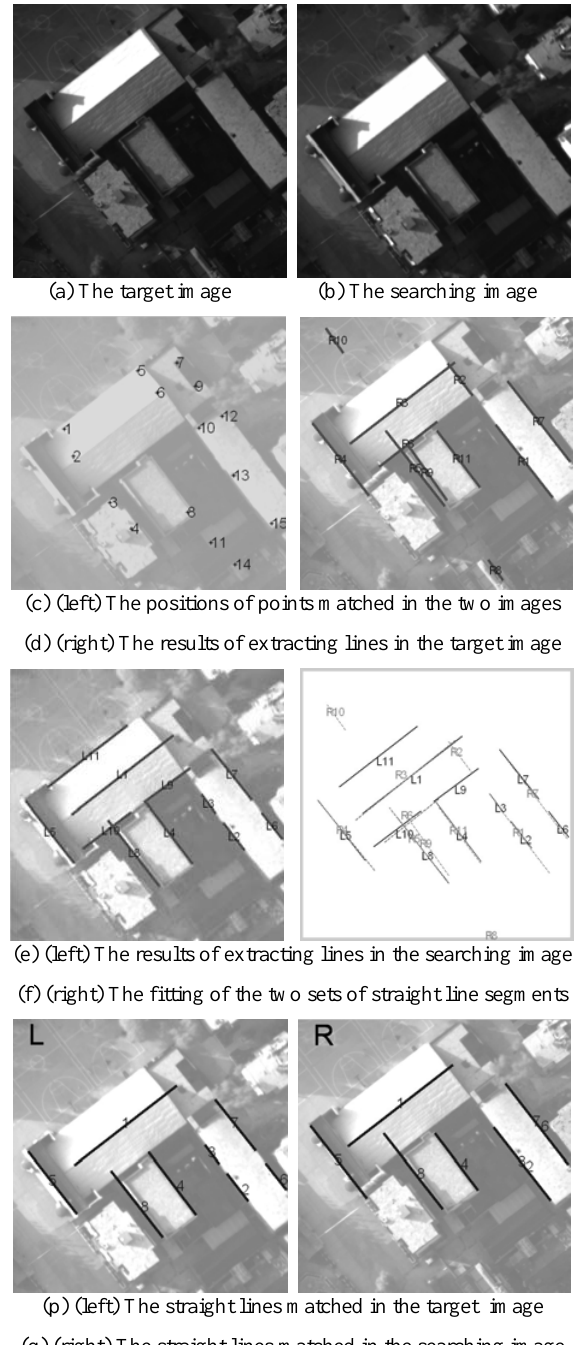
Figure 5. The original images and the results of